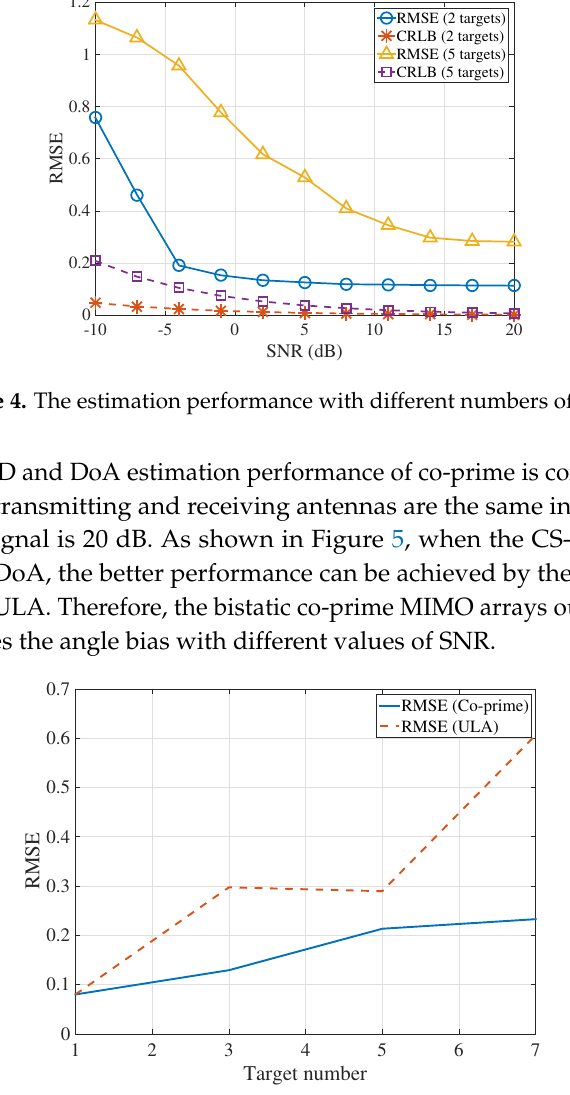
Figure 5. The estimation performance compared with ULA.